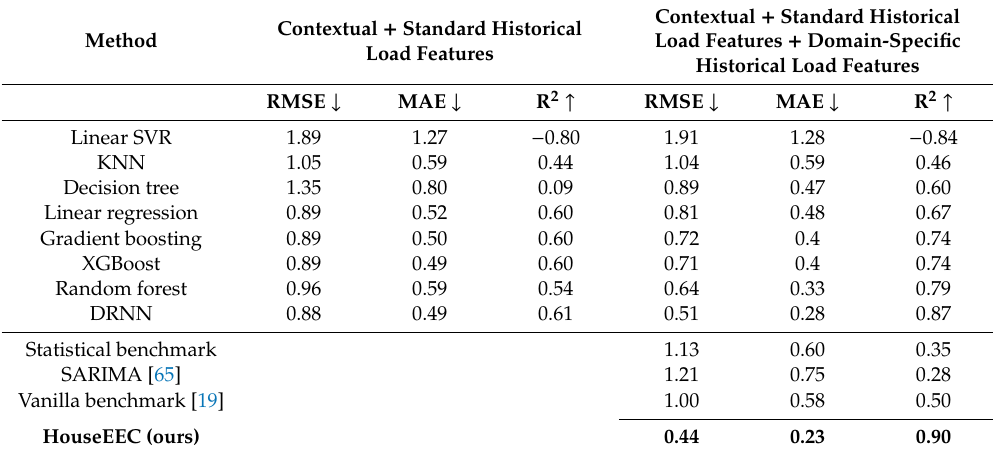
Table 2. Performance of methods using di ff erent feature sets.